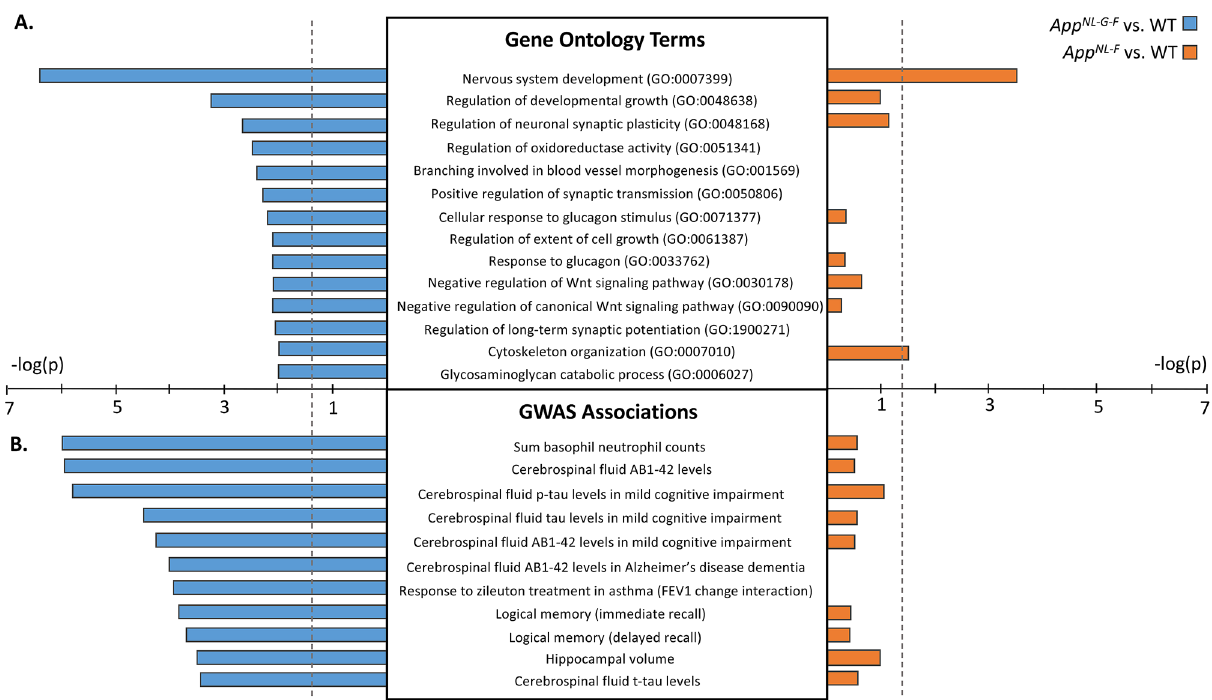
Figure 5. DMR-containing genes in App NL-G-F , but not App NL-F , mice are relevant to human AD. ( A ) The − log 10 ( p -value) of several AD-related gene ontology terms are showcased from the list of terms with significant enrichment (p < 0.05) in App NL-G-F . ( B ) The –l og 10 ( p -value) of several AD-related GWAS hits ( q < 0.05) in App NL-G-F are shown. P -value = 0.05 is marked with dashed vertical line. App NL-G-F mice: n = 5; App NL-F mice: n = 5; and WT mice: n =